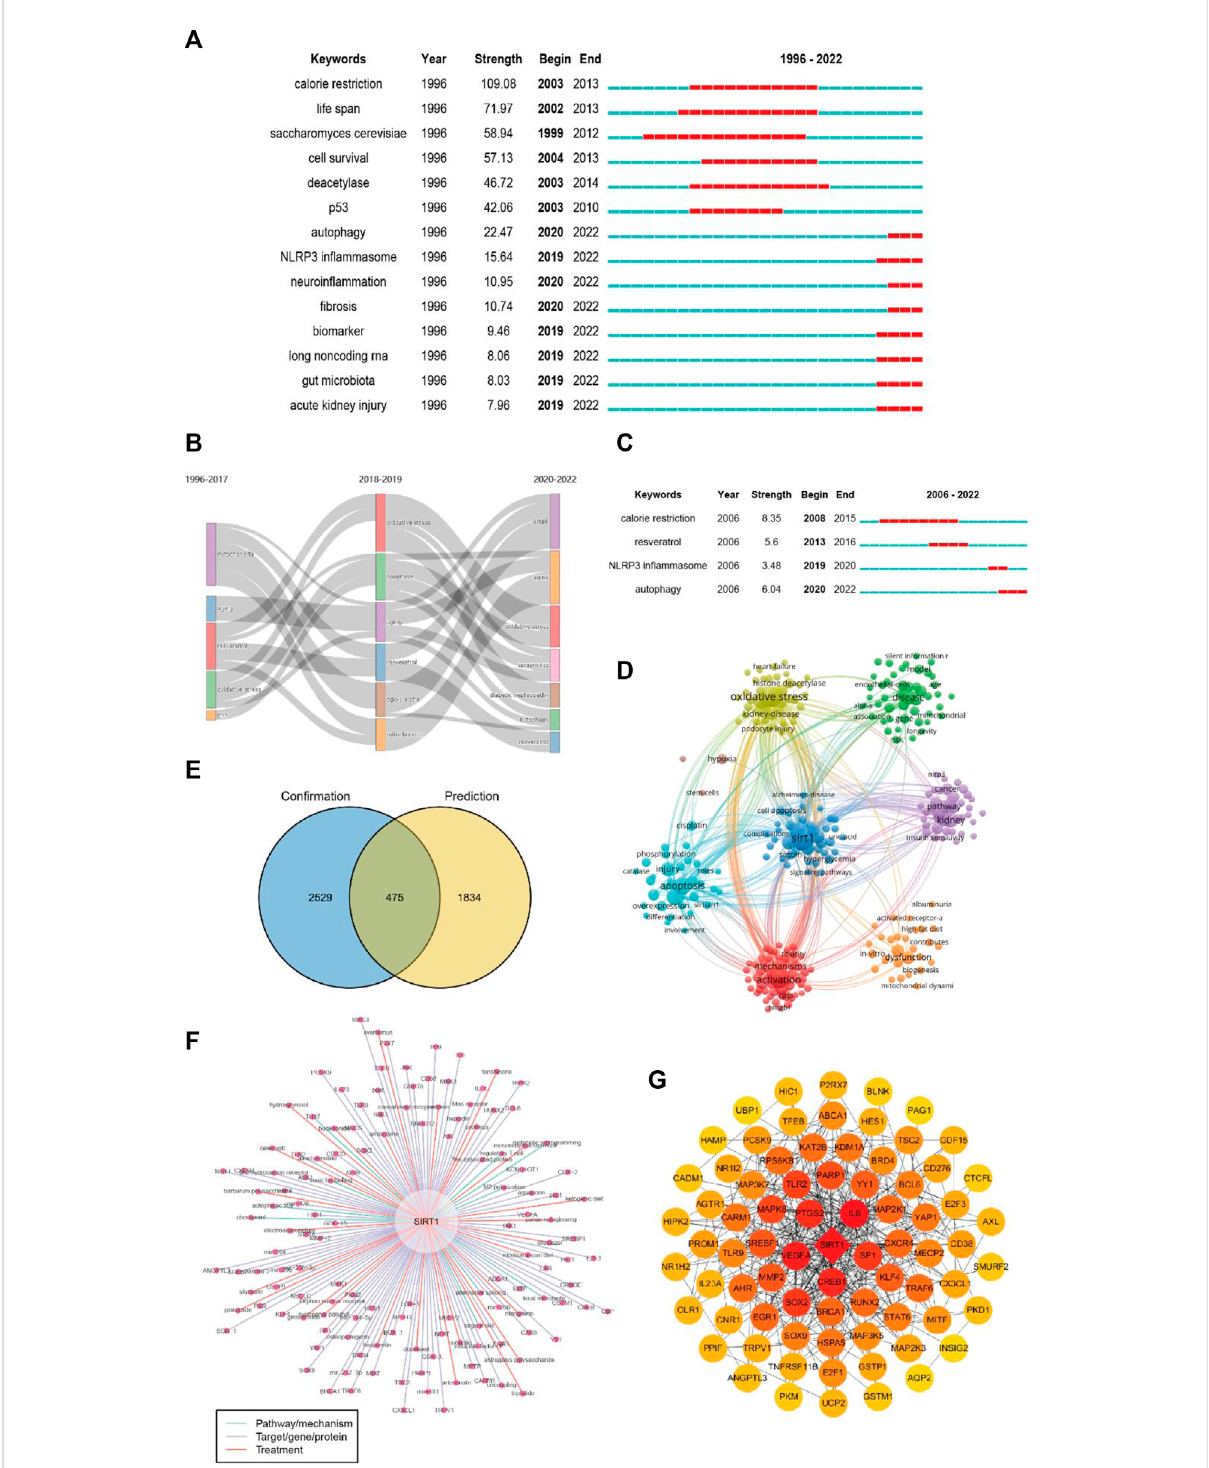
FIGURE 7 Keyword analysis. (A) Burst analysis concerning sirt1. (B) The thematic evolution of keywords. (C) Burst analysis concerning sirt1 in kidney disease. (D) Clustering of keywordsrelated to sirt1 in kidney disease. (E) Venn diagram for the keywords linking sirt1 and kidney diseases. (F) Potential research topics linking sirt1 and kidney diseases. (G) PPI network for the targets related to sirt1 in kidney